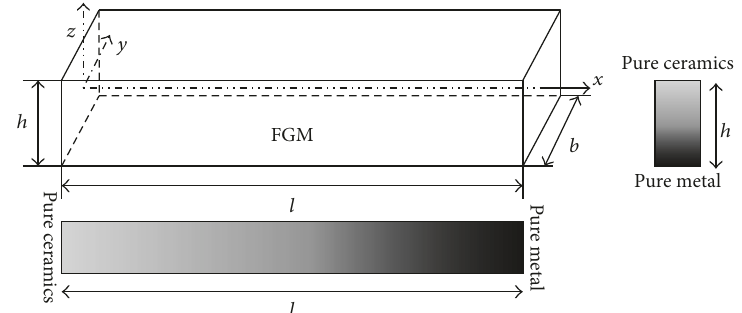
Figure 1: Configuration of an FGM